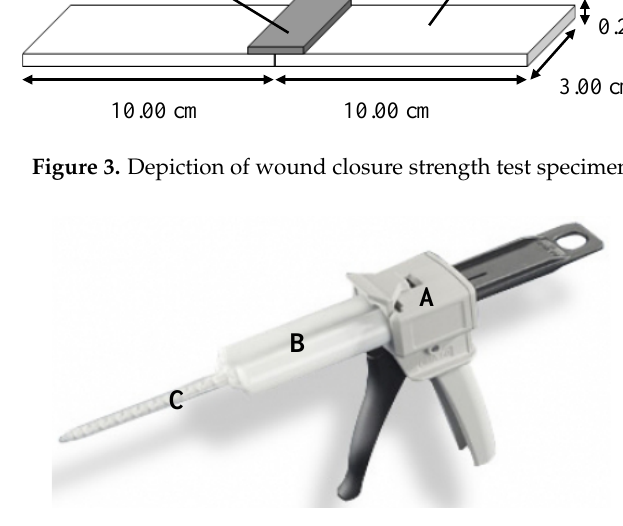
Figure 4. Mixpac mixing device. (A) Dispensing gun; (B) dual barrel cartridge system (4:1); and (C) static mixer.